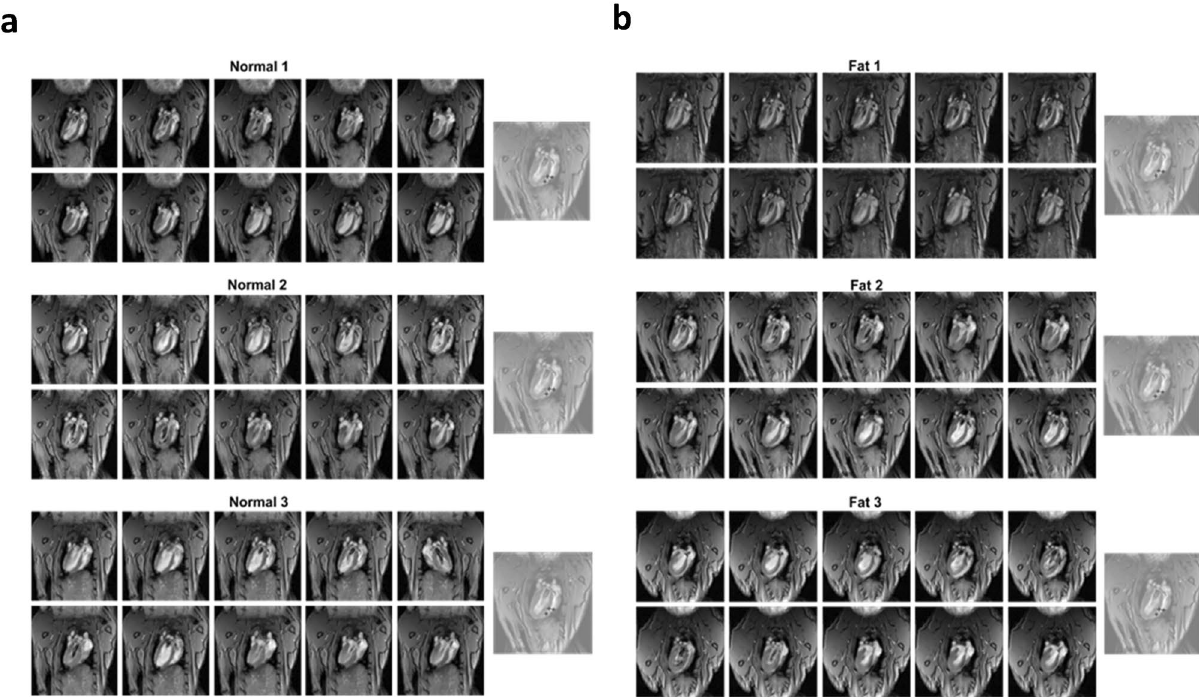
Figure 5. ( a ) Magnetic resonance imaging for normal group Syrian hamsters. ( b ) Magnetic resonance imaging for fat group Syrian hamsters. Column at the right end showed corresponding ROI